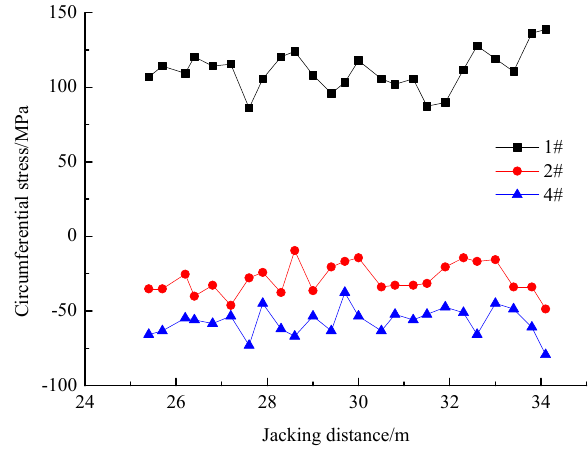
Figure 13. Circumferential stress.